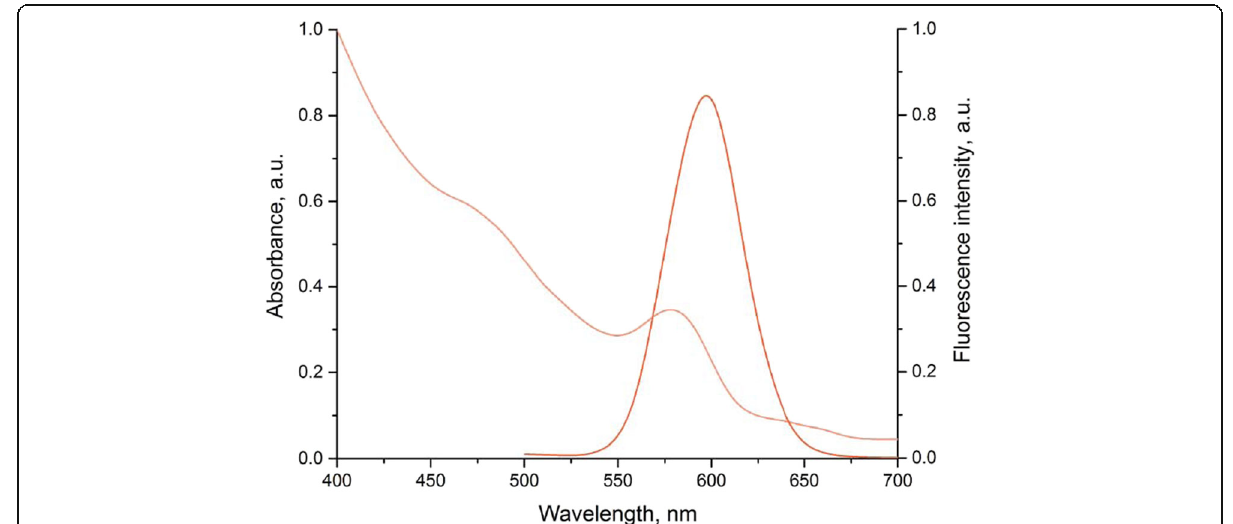
Fig. 2 Optical characteristics of the CdSe/ZnS core/shell quantum dots solubilized with HS − (PEG) 12 − COOH ligands